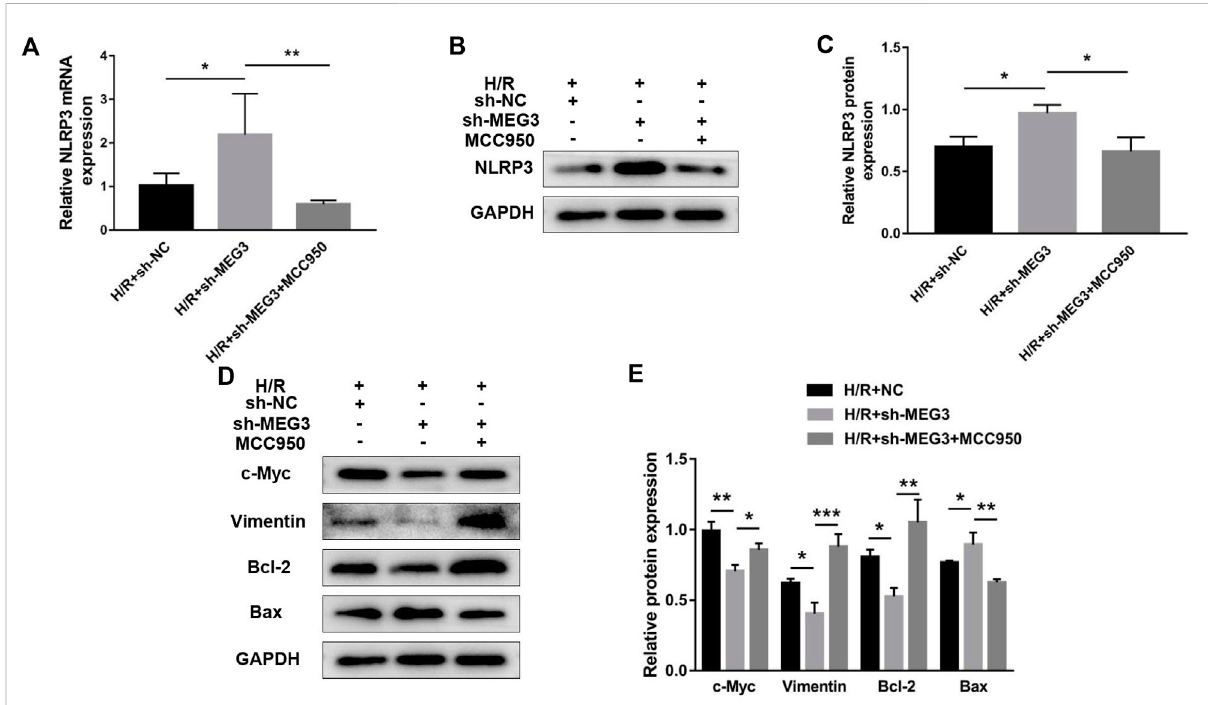
FIGURE 8 Suppressing NLRP3 expression reversed the effect of MEG3 knockdown on the expression level of NLRP3. qRT ‒ PCR [ (A) ; n = 4/group] and Western blotting[ (B,C) ; n = 3/group] wereperformed to evaluate NLRP3mRNA andproteinlevels in MEG3 knockoutHTR8/SVneo cells treated with MCC950. (D,E) Westernblottingwasperformedtoevaluatetheexpressionlevelsofc-Myc,Vimentin,Bcl-2,andBax( n =3/group).GAPDHwasused as an endogenous control. * p < 0.05; ** p < 0.01; *** p <